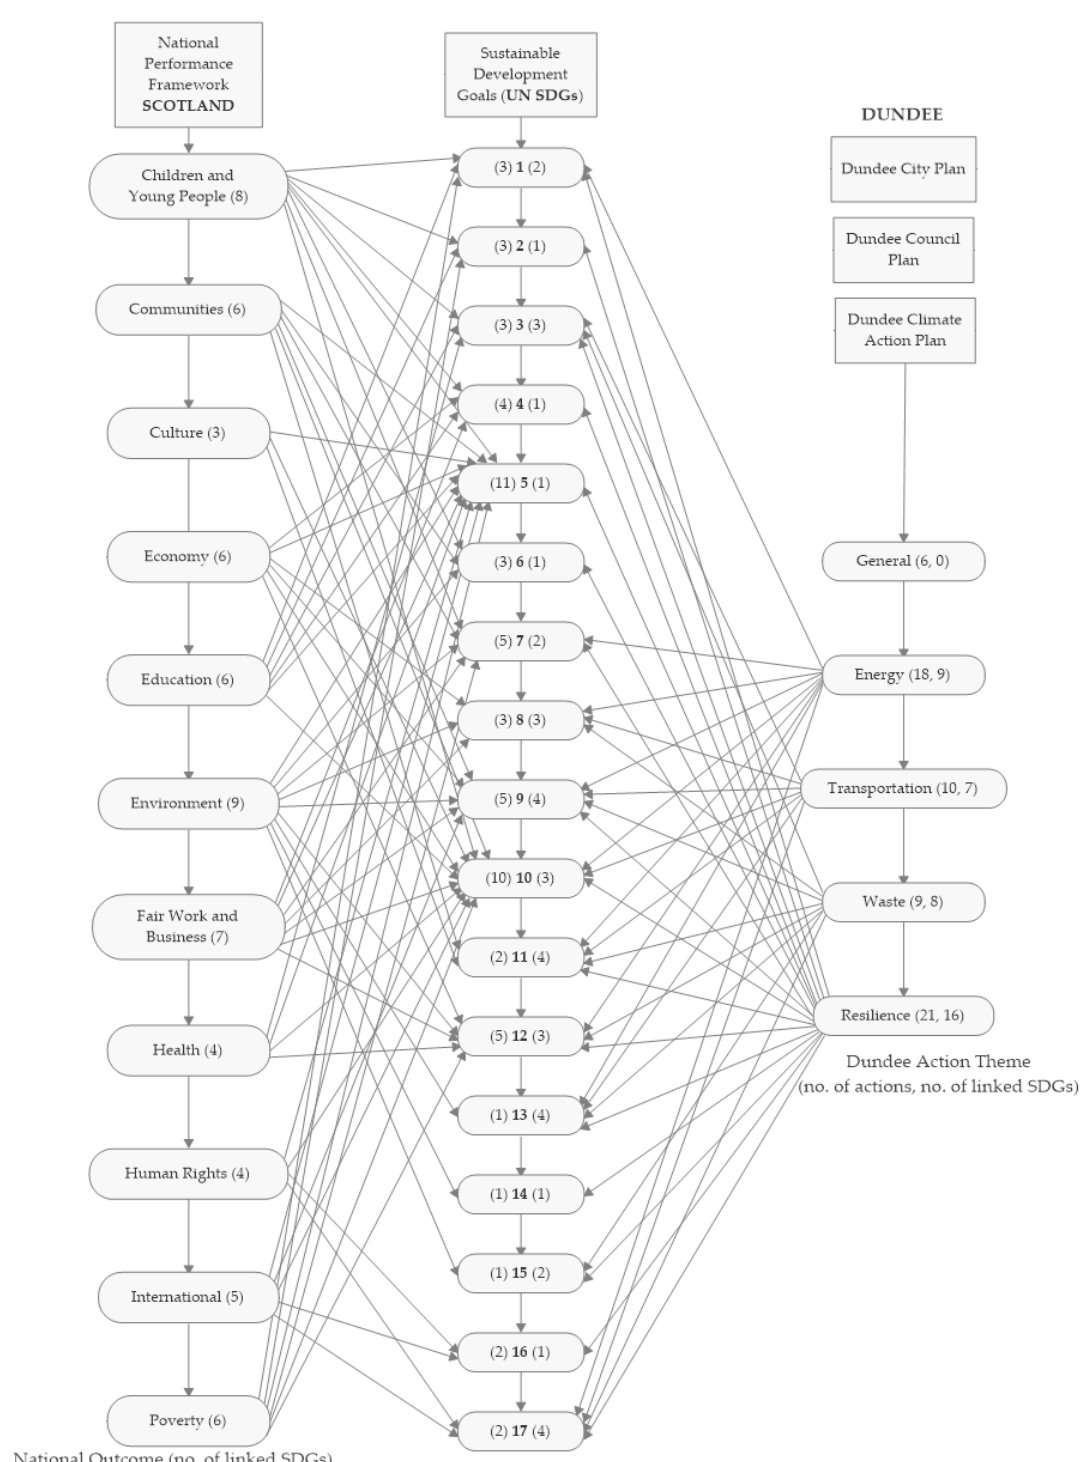
Figure 7. Scottish National Performance Framework (NPF) [25] outcomes and Dundee’s action themes mapped against the SDGs (source: authors’ mapping of Dundee City’s plans through the four Dundee Climate Action Plan (CAP) [24] themes of energy, transport, waste and resilience and the Scottish NPF [25] outcomes to the SDGs).